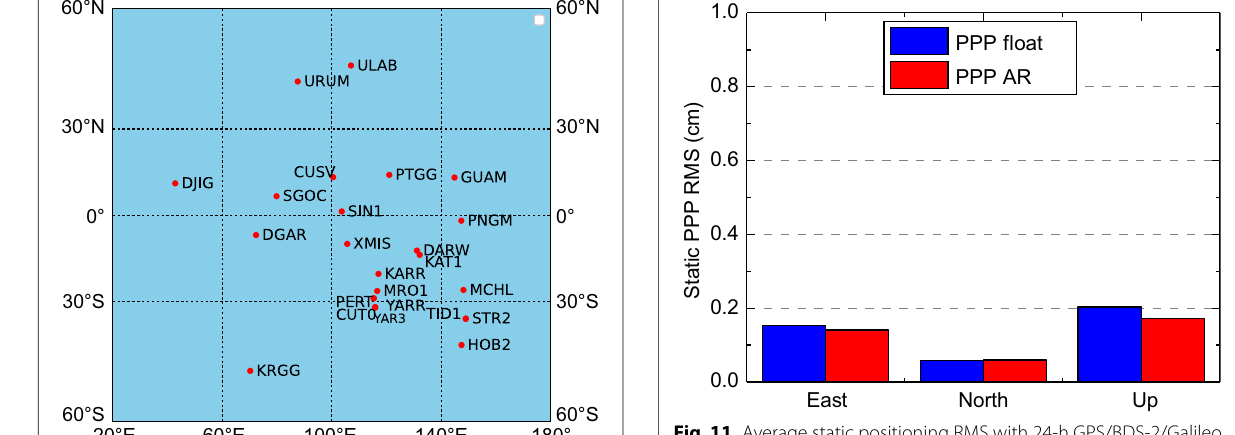
Fig. 11 Average static positioning RMS with 24-h GPS/BDS-2/Galileo data at 24 stations for the PPP float and AR